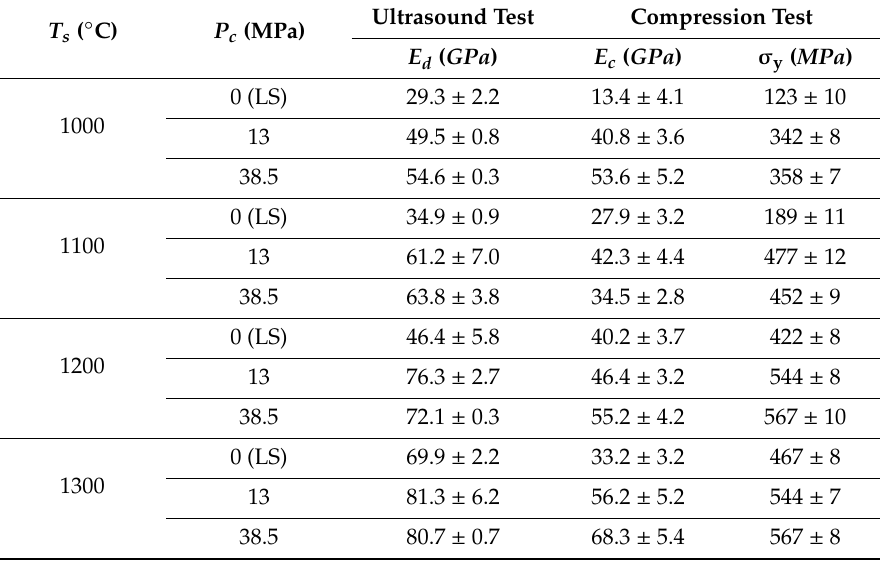
Table 2. Mechanical behavior: Young’s modulus and 0.2% o ff set yield